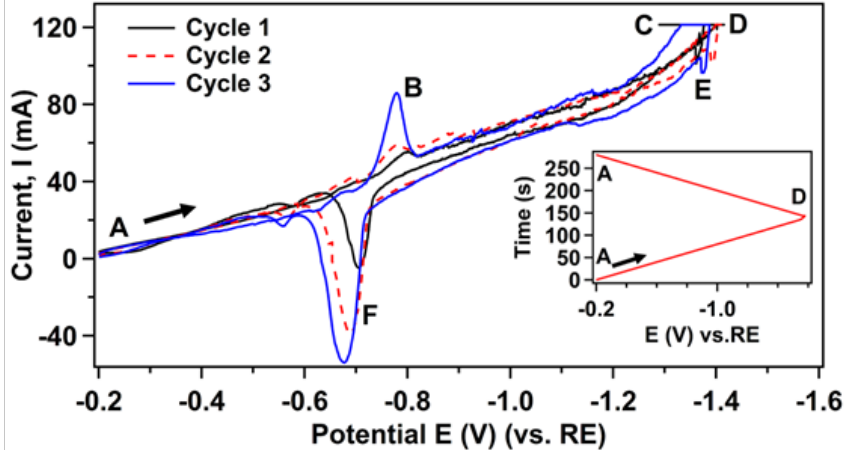
Figure 1. Cyclic voltammogram (CV) of the graphite electrode in the CaCl 2 -melt containing nano-SiO 2 at 855 ◦ C. Potential E was applied on the graphite electrode vs. Mo-RE at a scan rate of 10 mV/s. The saturation of the current above 120 mA at a higher potential region is due to exceeding the limit of the polarization system. The inset of the figure shows the first cycle of the applied negative potential with respect to the Mo-RE.